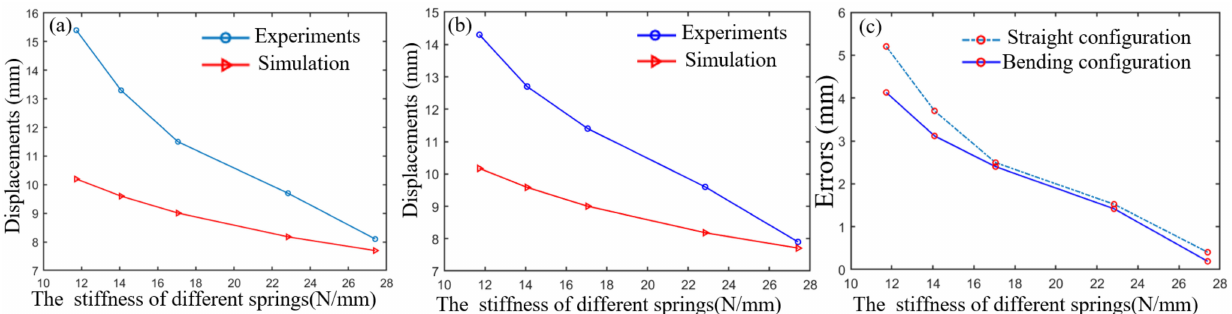
Figure 26. The 1 N load experiments on the distal segment with the bending configuration.